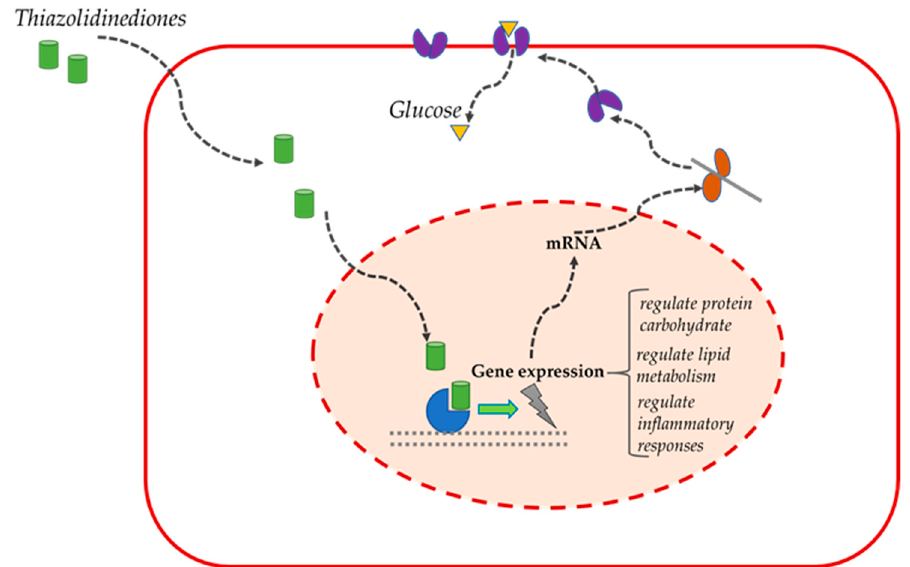
Figure 9. Thiazolidinediones’ basic mechanisms and signaling.